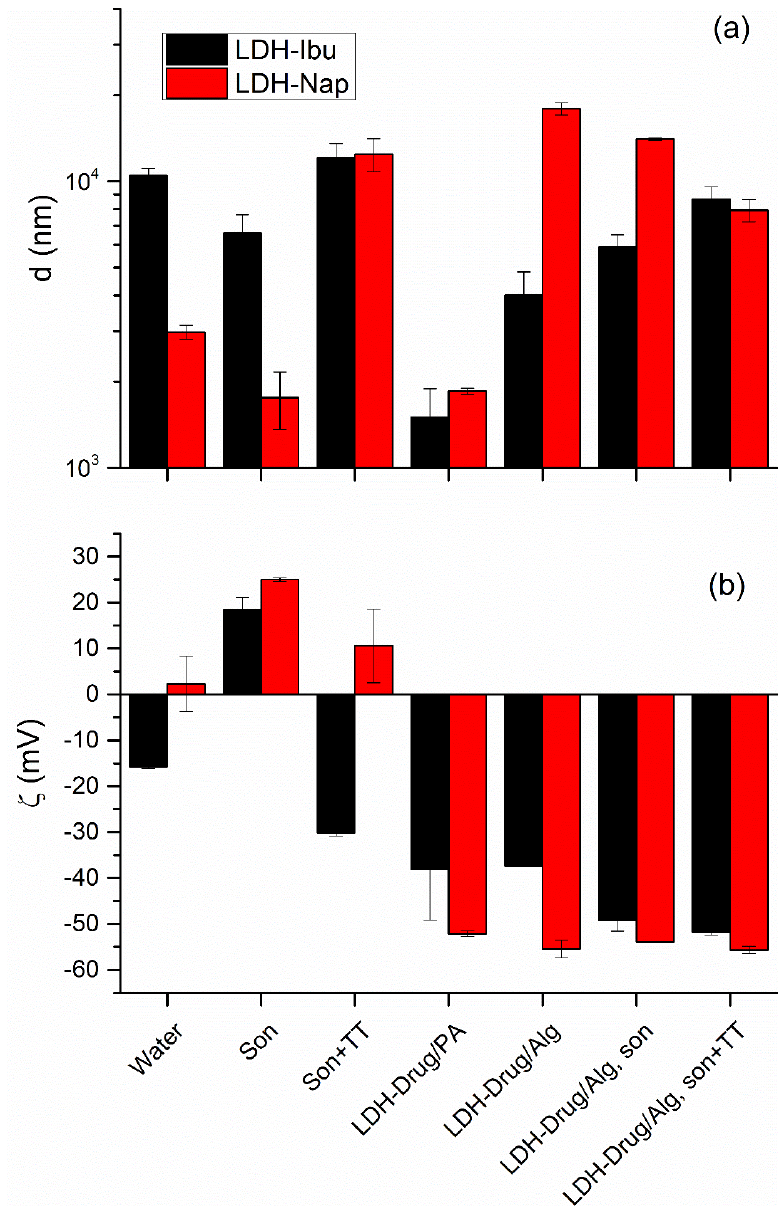
Figure 2. Hydrodynamic apparent diameter, d ( a ) and zeta potential, ζ ( b ) values obtained for LDH- Ibu and LDH-Nap dispersions (1 g L −1 ) in different media and preparation conditions (son, sonicated; TT, thermal treatment; PA, 2% polyacrylate dispersion ).